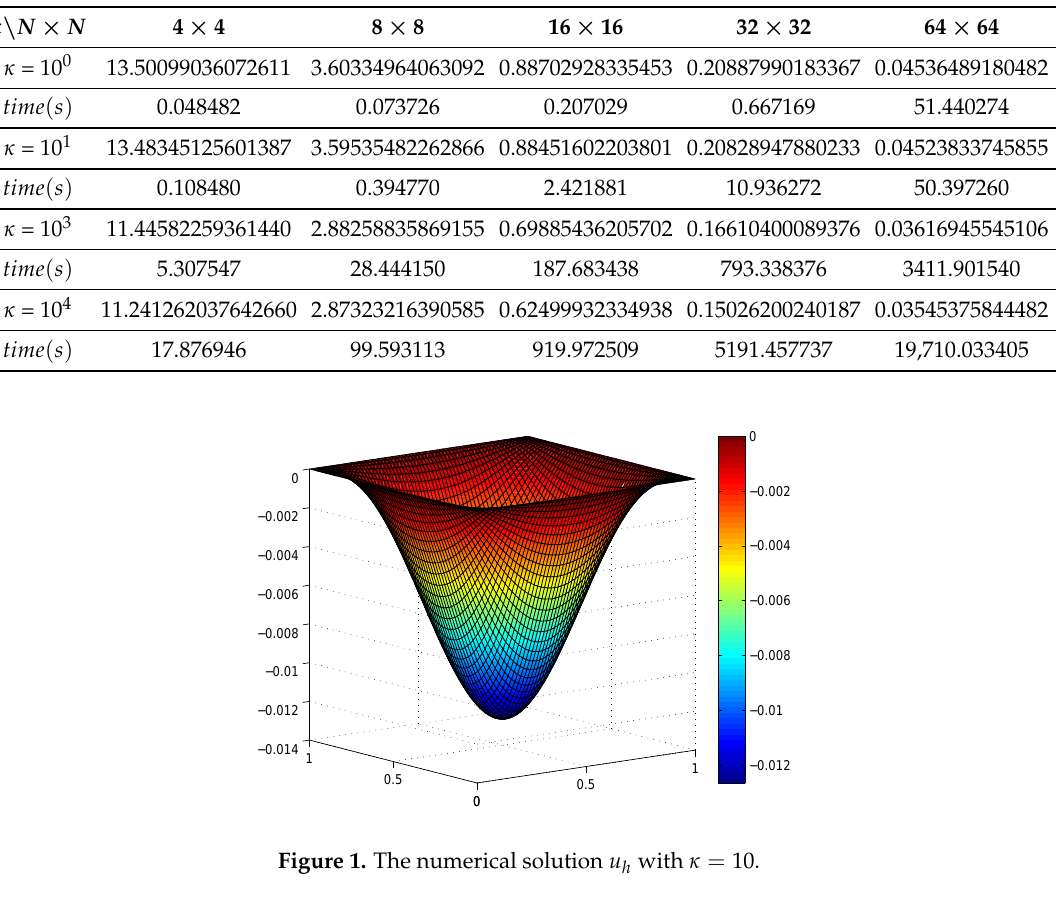
Table 1. Errors of (cid:107) u − u h (cid:107) h and the CPU time.